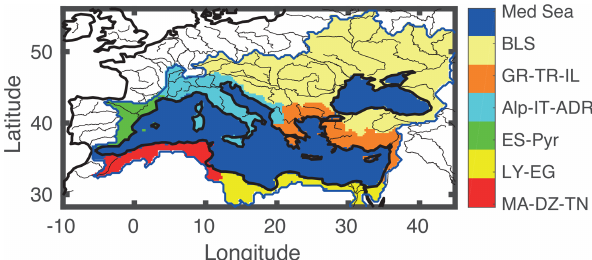
Figure 1. Region of interest. Sub-basins have been computed using a hydrological model (Wu et al., 2011), and rivers are from HydroShed (http://www.hydrosheds.org/, last access: 24 Jan- uary 2019). See text for the definition of the